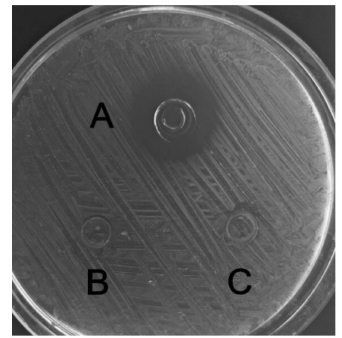
Figure 6. The antimicrobial activity of recombinant C–L against S. aureus ATCC25923. A, recombinant C–L (2 µ g); B, fusion SUMO–C–L (10 µ g); C, the negative control, sodium phosphate buffer